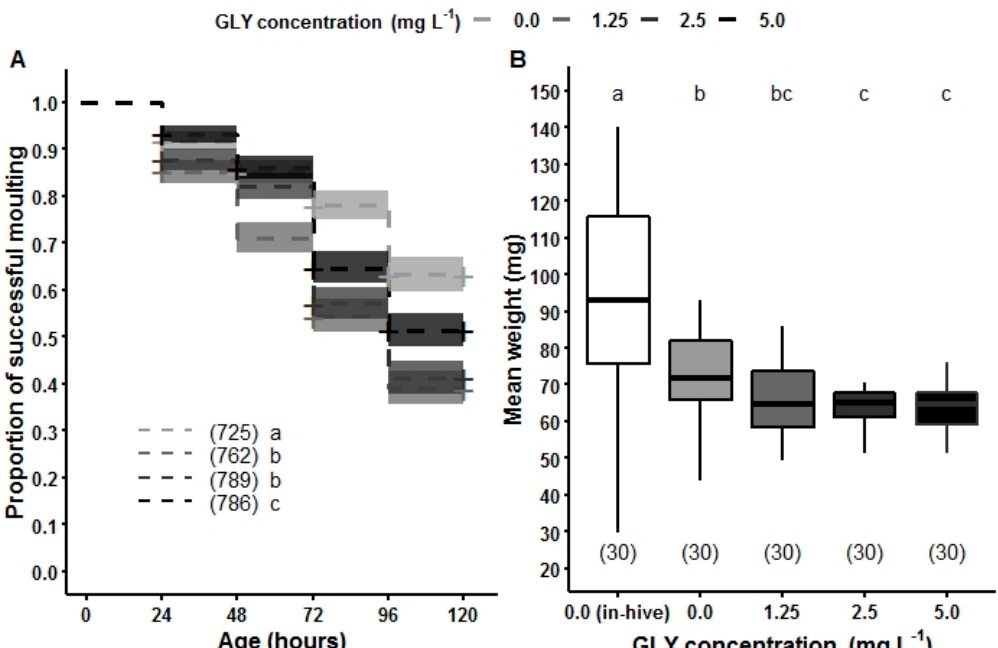
Figure 7. Effects of GLY on larval development of honey bee brood. Larvae reared in vitro were exposed to food contaminated with GLY (0 mg L − 1 , 1.25 mg L − 1 , 2.5 mg L − 1 , 5.0 mg L − 1 , greyscale) during the larval feeding period (0–120 h of age). ( A ) Proportion of larvae without delay in moulting and ( B ) larval weight at the end of the feeding period. White: data for control larvae reared in-hive. Curves of successful moulting are plotted with their confidence interval (95%) for each treatment. The + indicate time points with censored data. Main effects in development data: AFT model followed by a log-rank test for post hoc comparisons was carried out to analyse. Main effects in weight data: GLM followed by Tukey post hoc comparisons. Numbers in brackets indicate the number of larvae assessed for each treatment. Different letters indicate significant differences among treatments.